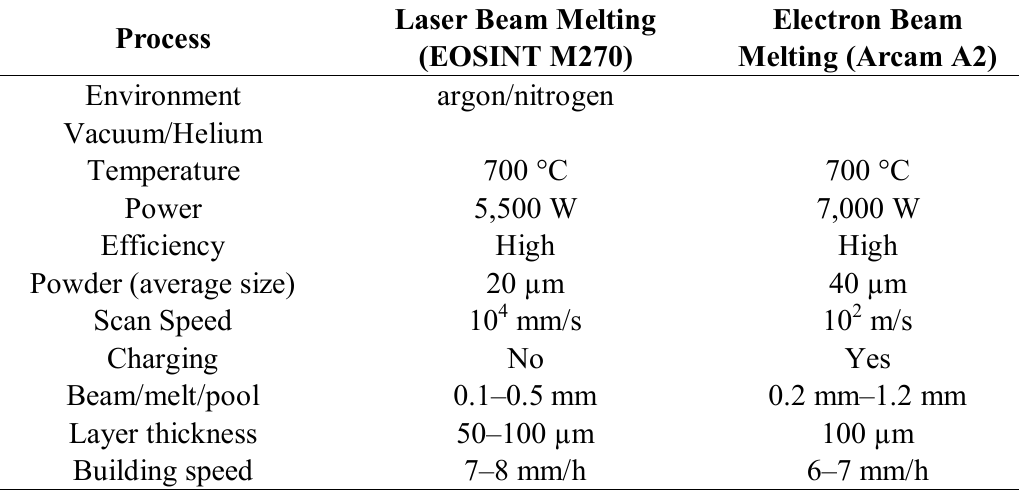
Table 1. Operative conditions for EBM vs. LBM systems.